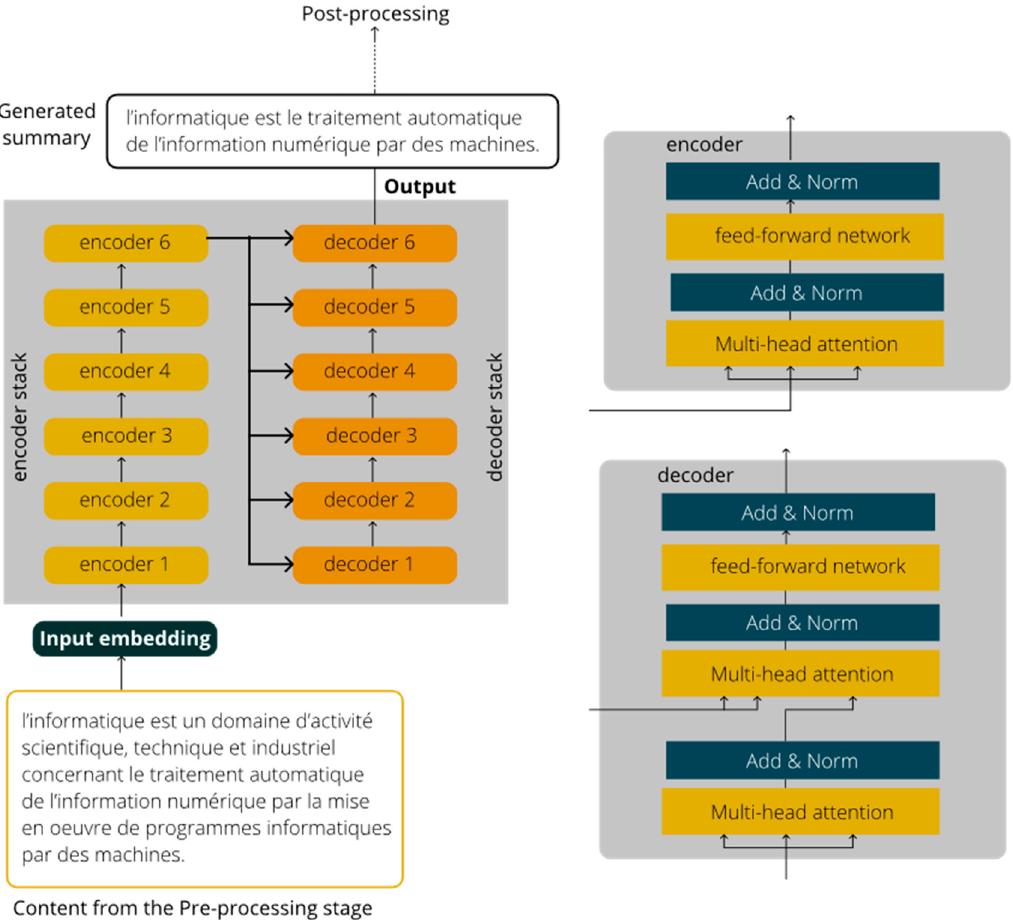
Figure 3. Data flow in transformer.